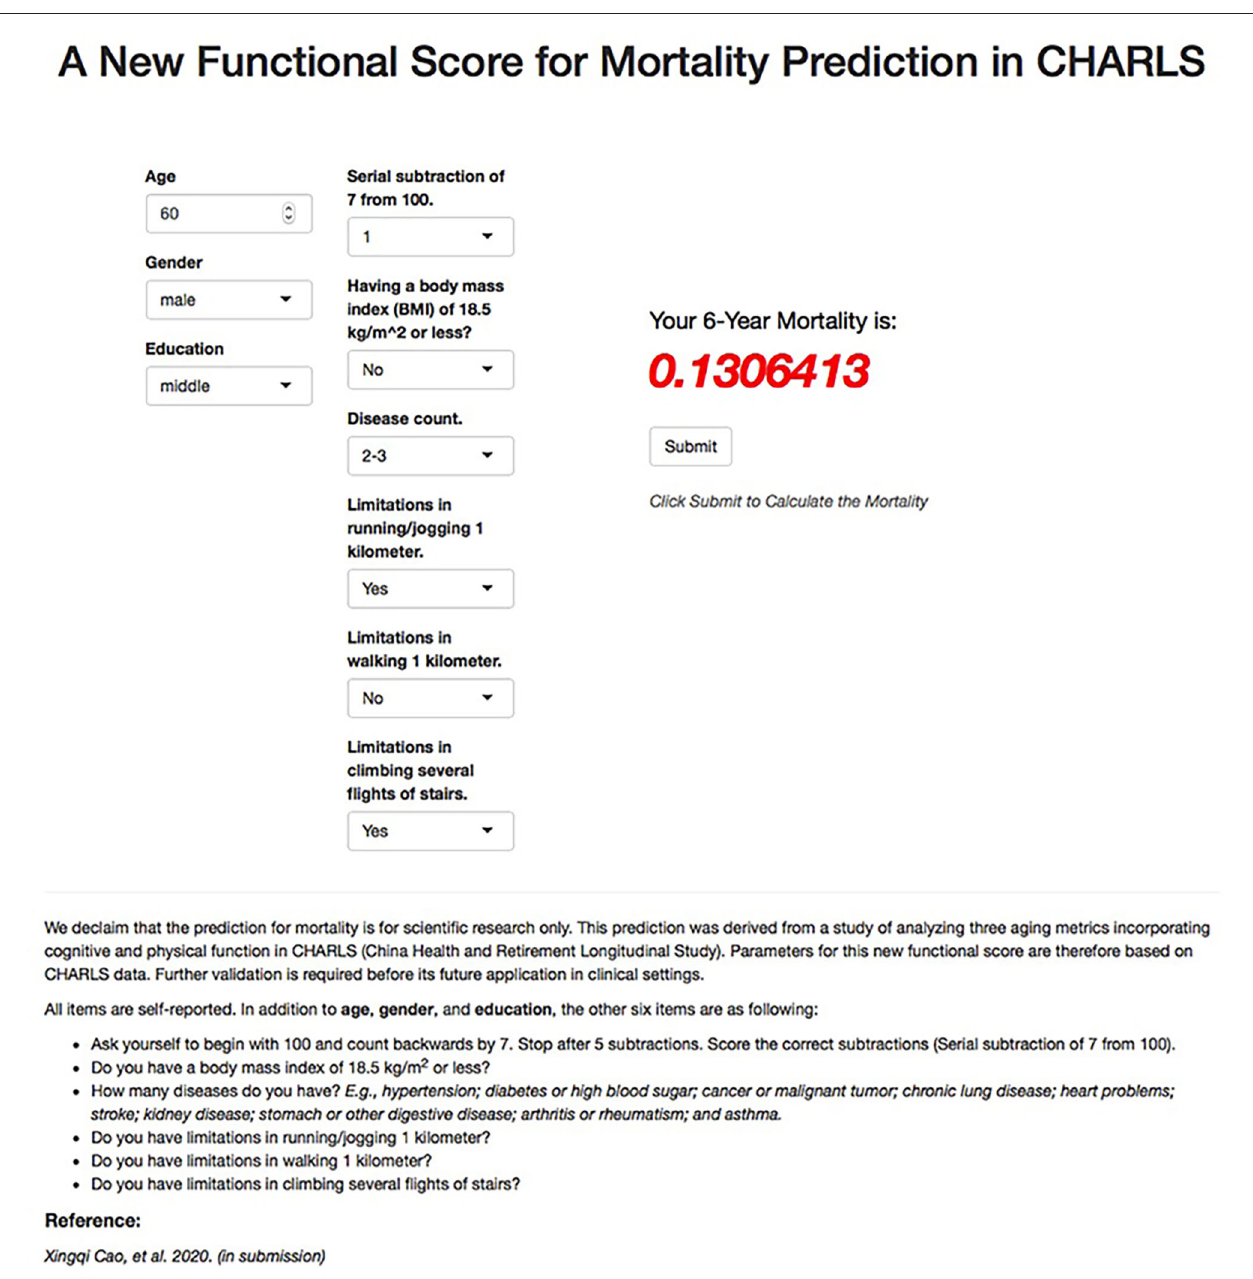
FIGURE 3 | Illustration of all-cause mortality prediction for new functional score using the online tool for a 60-year-old Chinese person. CHARLS, China Health and Retirement Longitudinal